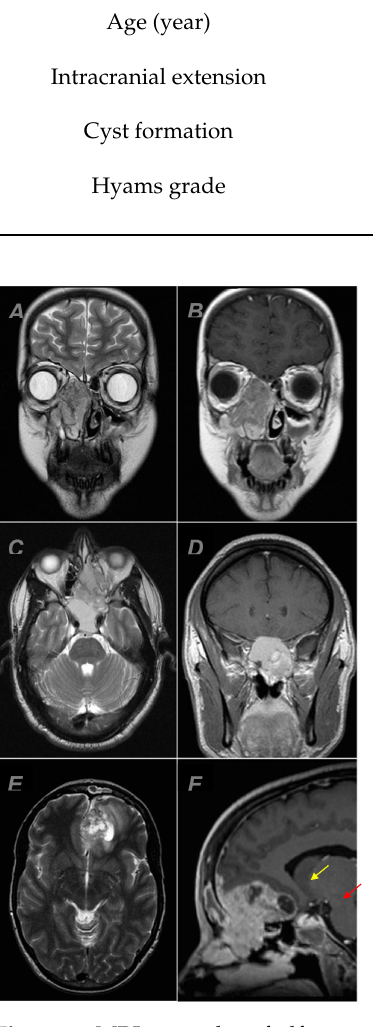
Figure 1. MRI examples of olfactory neuroblastoma centered in the nasal cavity. Coronal T2 ( A ) and T1 + C ( B ) showing an olfactory neuroblastoma without intracranial extension. Axial T2 ( C ) and coronal T1 + C ( D ) showing an olfactory neuroblastoma with intracranial extension and no peritumoral cyst formation. Axial T2 ( E ) and sagittal T1 + C ( F ) showing an olfactory neuroblastoma with intracranial extension and at least one focus of peritumoral cyst formation (red arrow). The area delimited by the yellow arrow was favored to represent necrosis, which was confirmed on